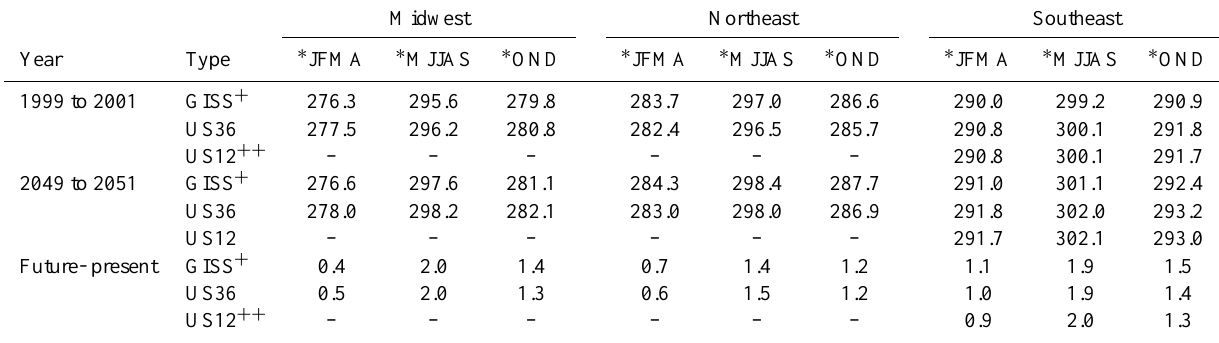
Table 5. Average zonal temperatures of GISS and MM5 outputs for the present and future